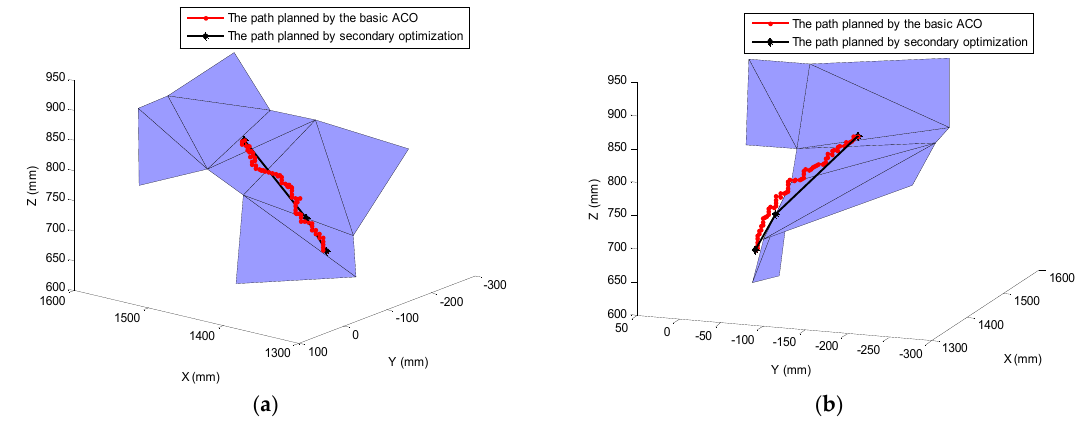
Figure 9. Welding robot path planning based on the Secondary Optimization of ACO (SO-ACO). ( a ) View A; ( b ) View B.